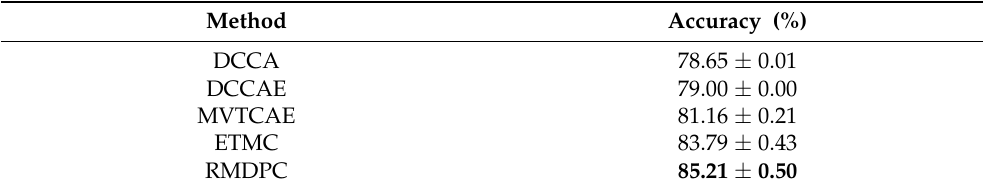
Table 5. Comparison with other multi-view deep classification